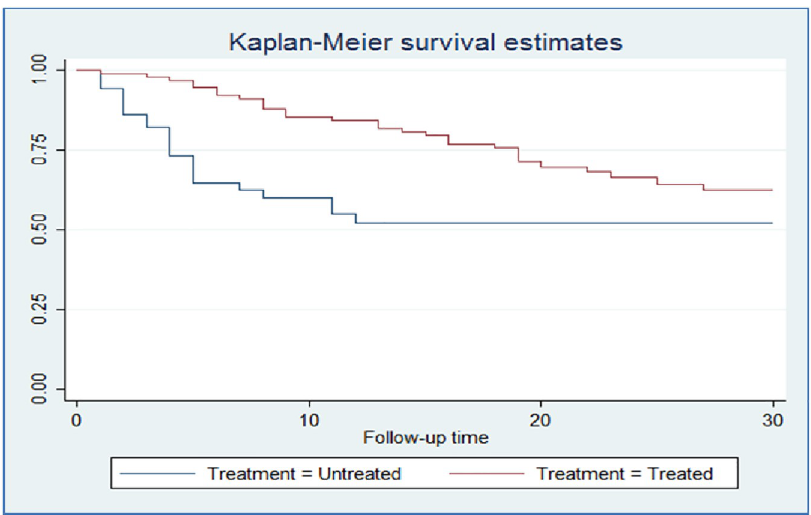
Fig 1. 30-day survival curve by treatment of candidemia (RR vs.